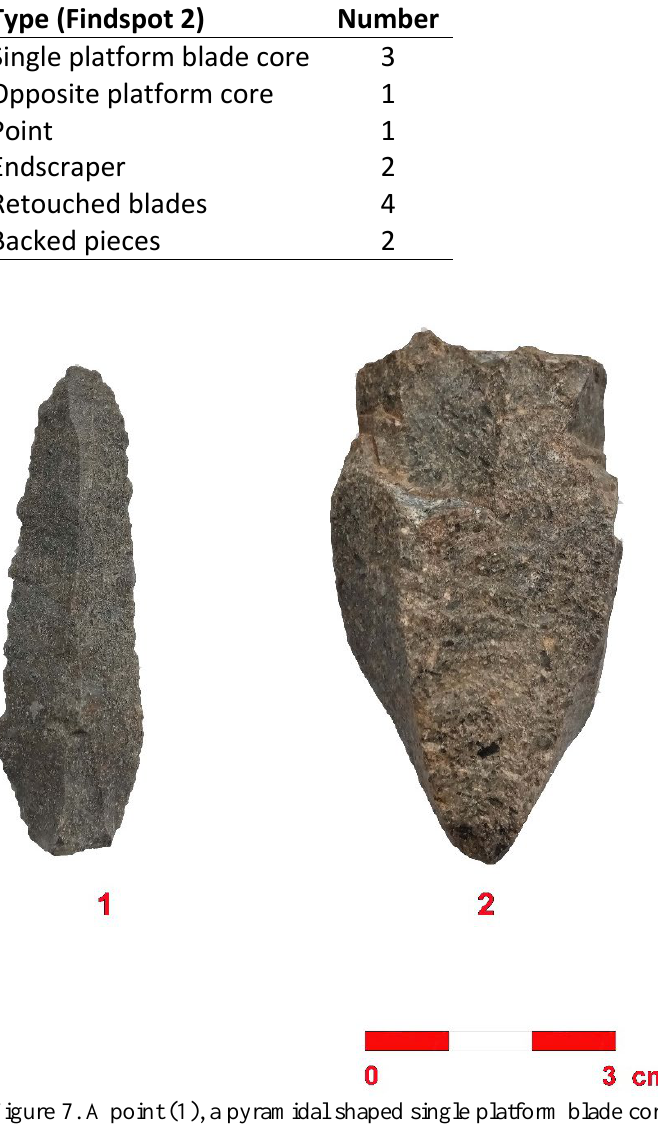
Table 3. The Upper Palaeolithic lithic collection.